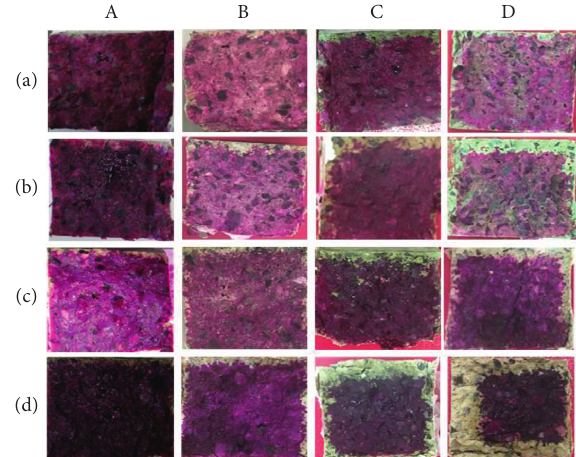
Figure 5: Images of concrete specimens sprayed with phenolphthalein indicator (1:100% OPC (G0), 2:70% OPC (G30), 3:50% OPC (G50), and 4: 30% OPC (G70)). Note. A B, C, and D are 3-, 7-, 28-, and 56-day results for concrete groups in ACC, respectively.